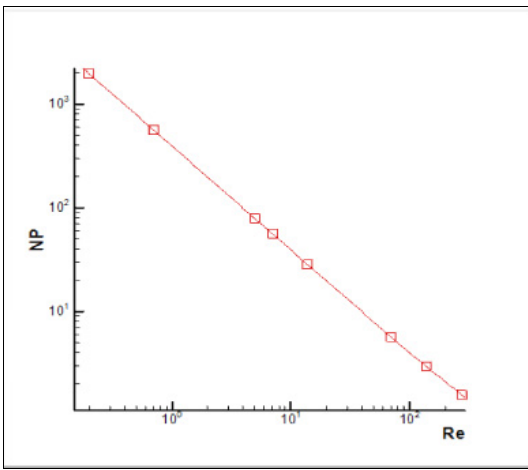
Fig. 2. Variation of power number as function of Reynolds number.